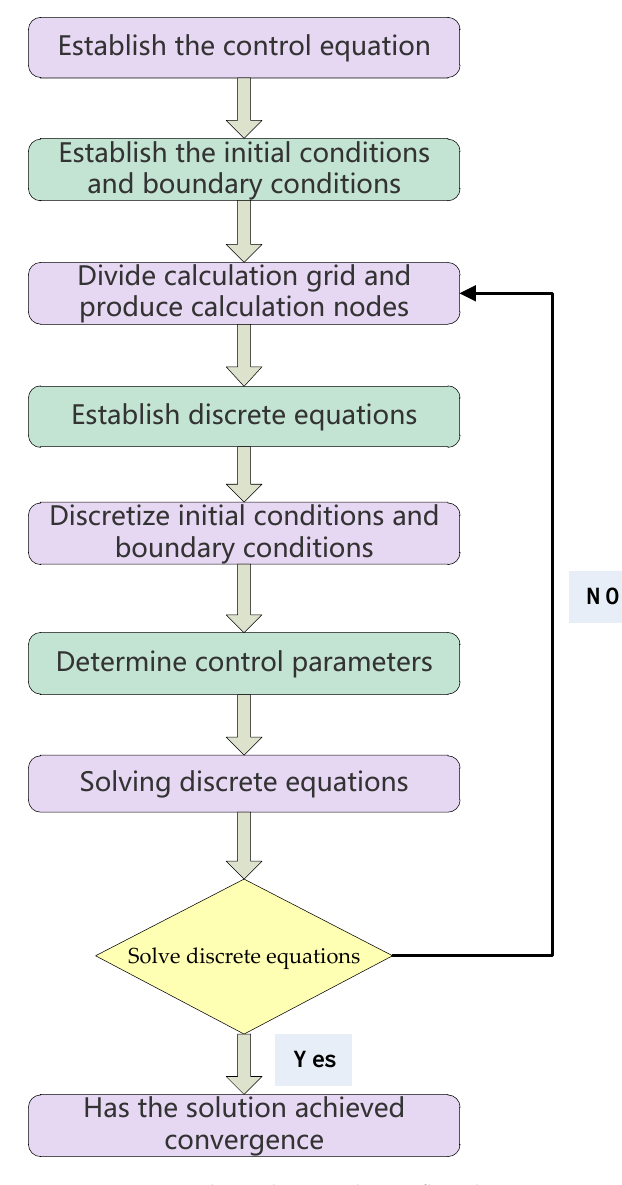
Figure 6. Numerical simulation solution flowchart.